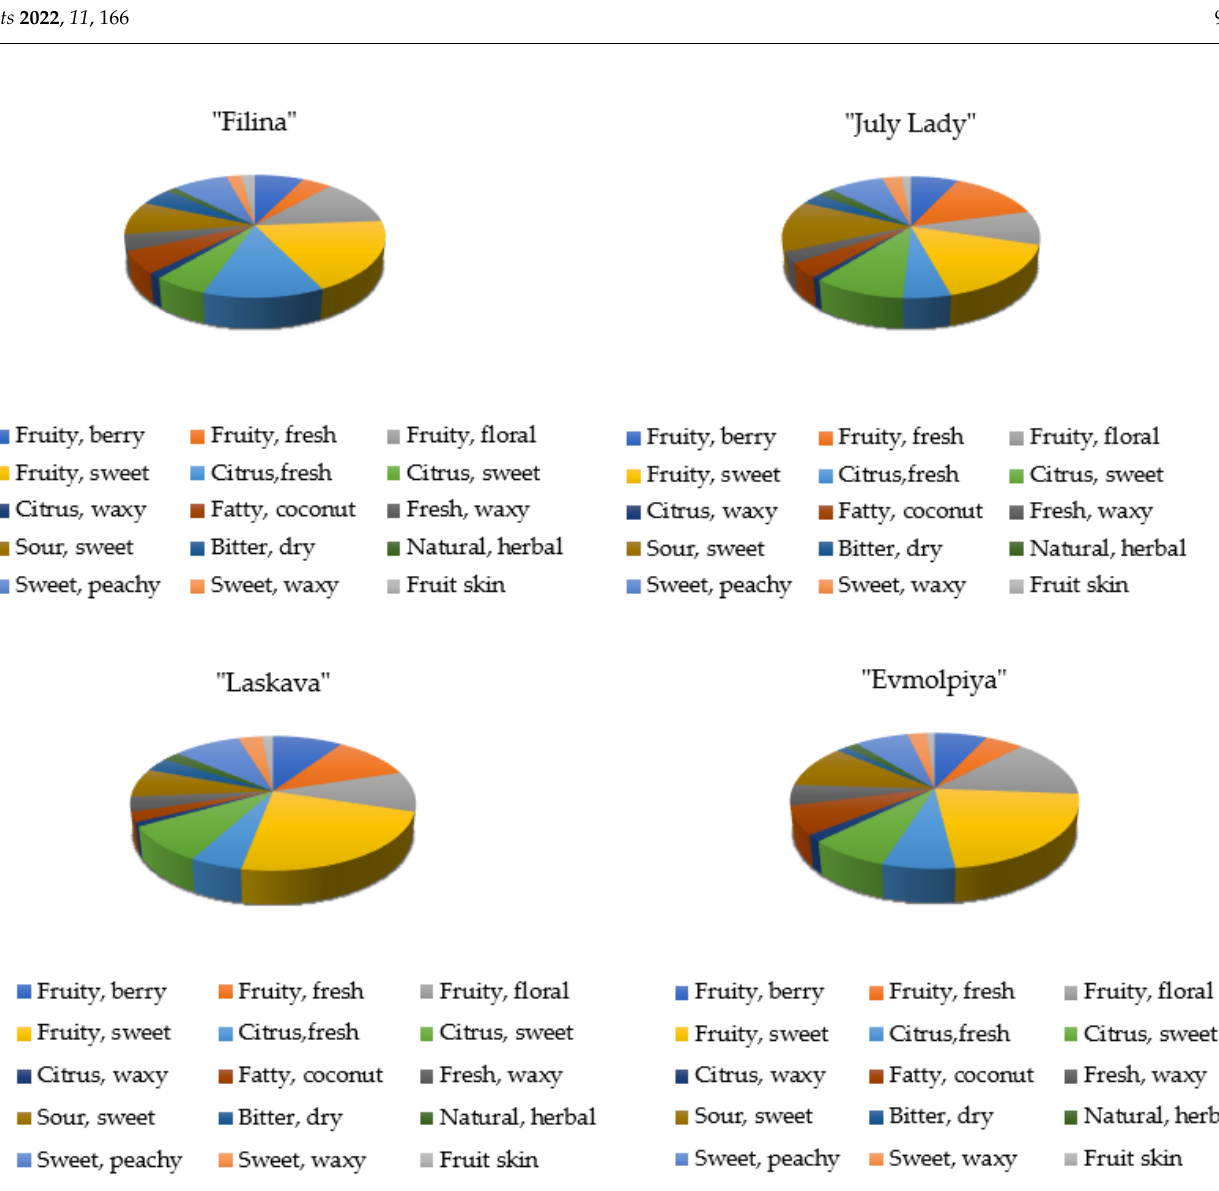
Figure 3. Flavor component distribution (%) in flat peach varieties.